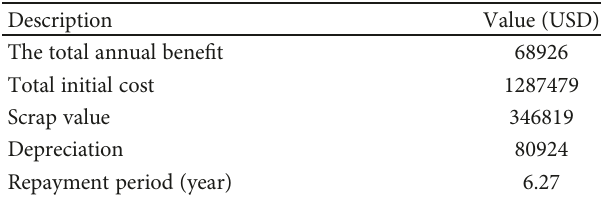
Table 8: Economic indicators for PBP.